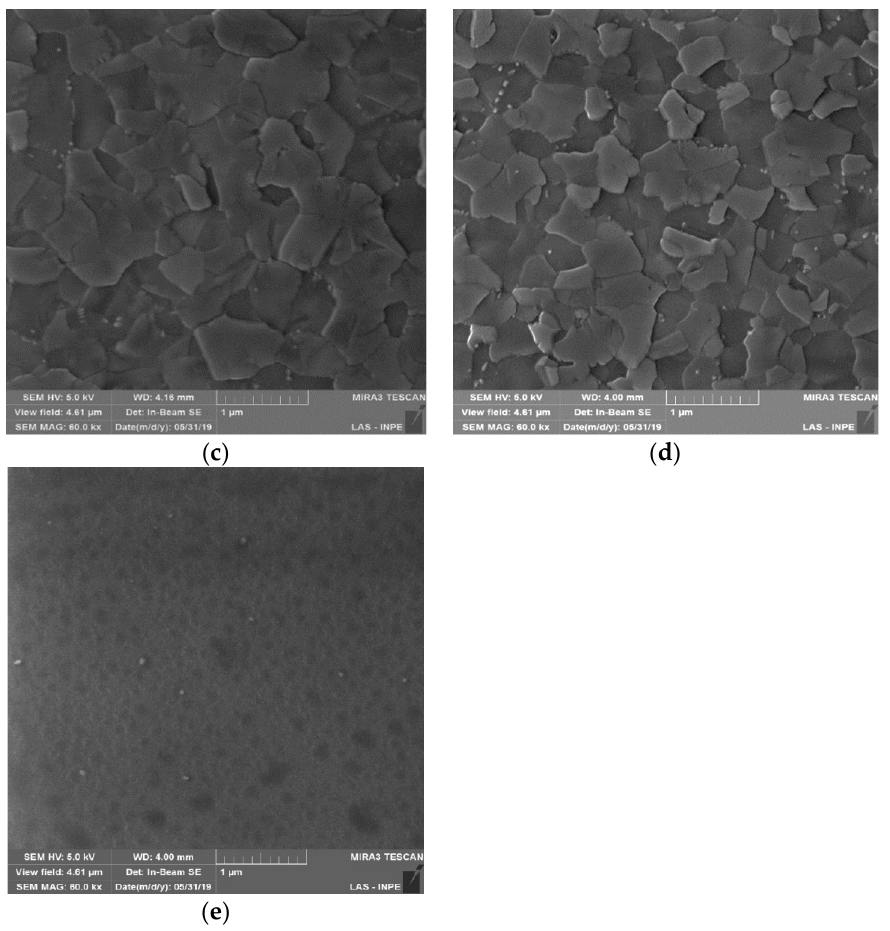
Figure 6. FESEM images of TiO 2 films deposited under RF power of ( a ) 100 W in remote mode, ( b ) 100 W in direct mode, ( c ) 150 W in remote mode, ( d ) 150 W in direct mode and ( e ) 100 W in remote mode (TiO 2 /Al 2 O 3 nanolaminate).